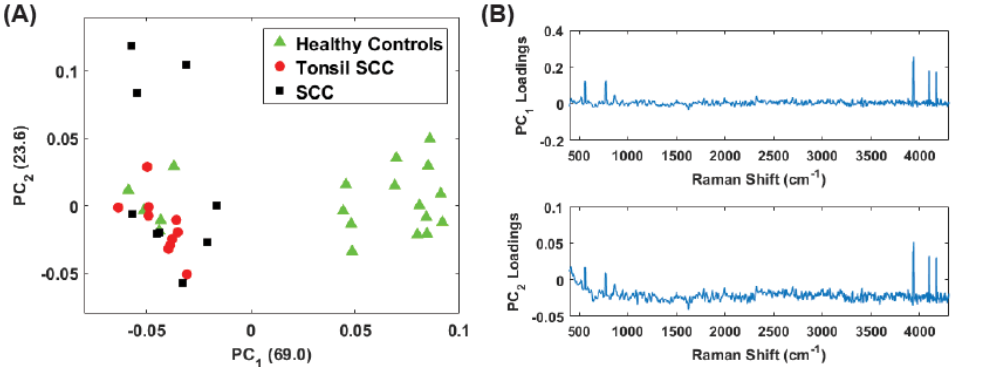
Figure 8. ( A ) Plot of the first two PC scores for only the unstained tissue samples. The analysis was performed in the Raman shift region from 400 cm − 1 –4300 cm − 1 and show good separation between the healthy and diseased tissue classes. The numbers in parentheses represent the information content associated with each principal component. ( B ) Corresponding loadings plots for the PCs shown in ( A